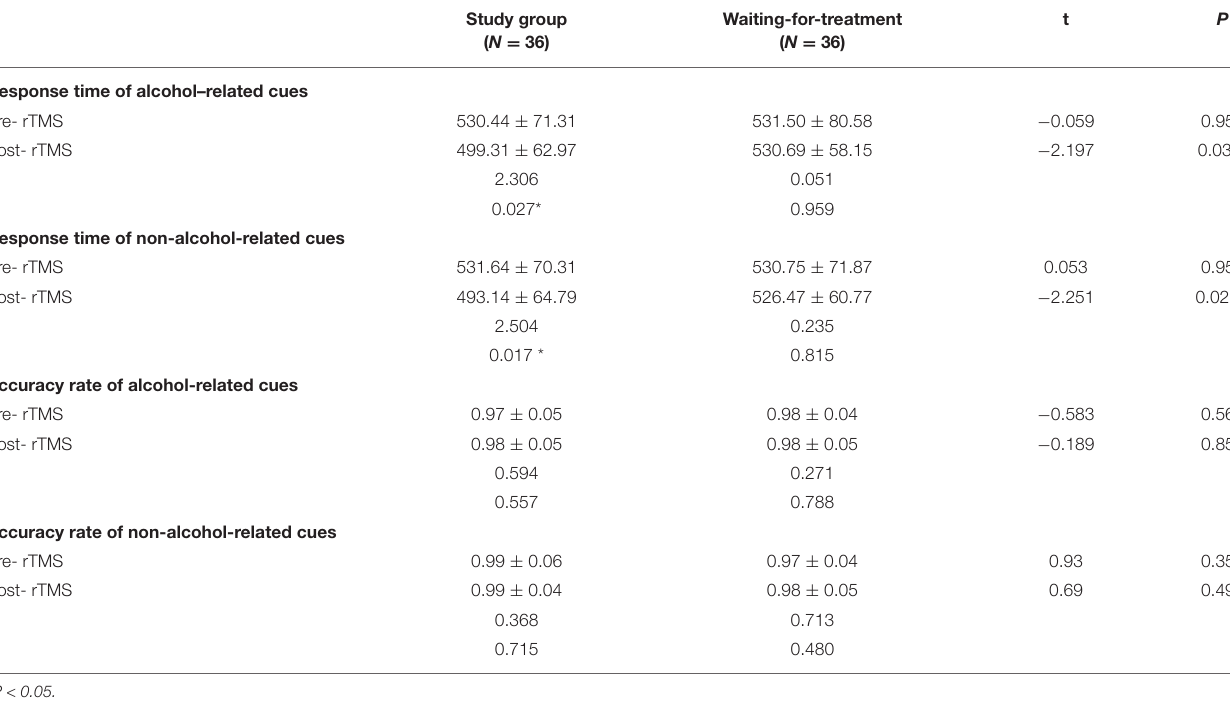
TABLE 2 | Pre-post comparison of response time (ms) and accuracy rate (%) after rTMS in the oddball paradigm.